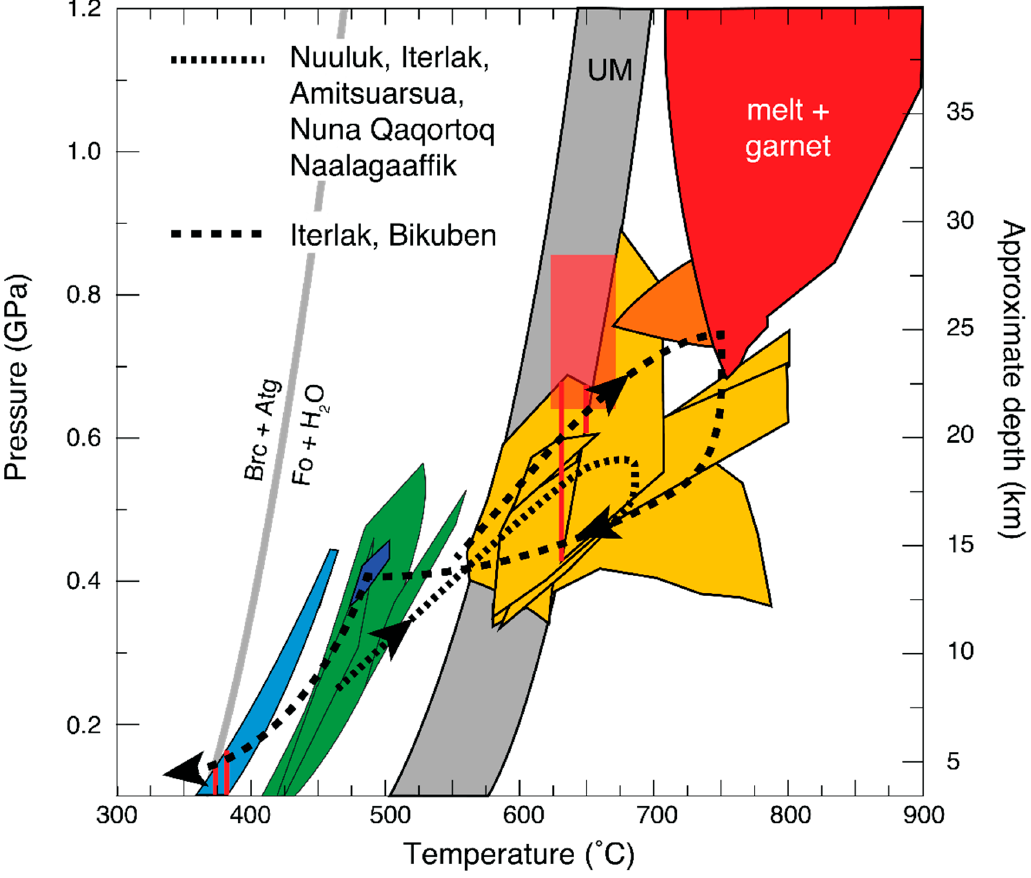
Figure 8. Compilation of all pseudosection and thermobarometry (in red) P–T constraints and the proposed metamorphic P–T paths derived from these. Prograde greenschists in green, amphibolites in yellow, granulite in orange, migmatites in red, ultramafic rocks in grey, retrograde assemblages in blue.